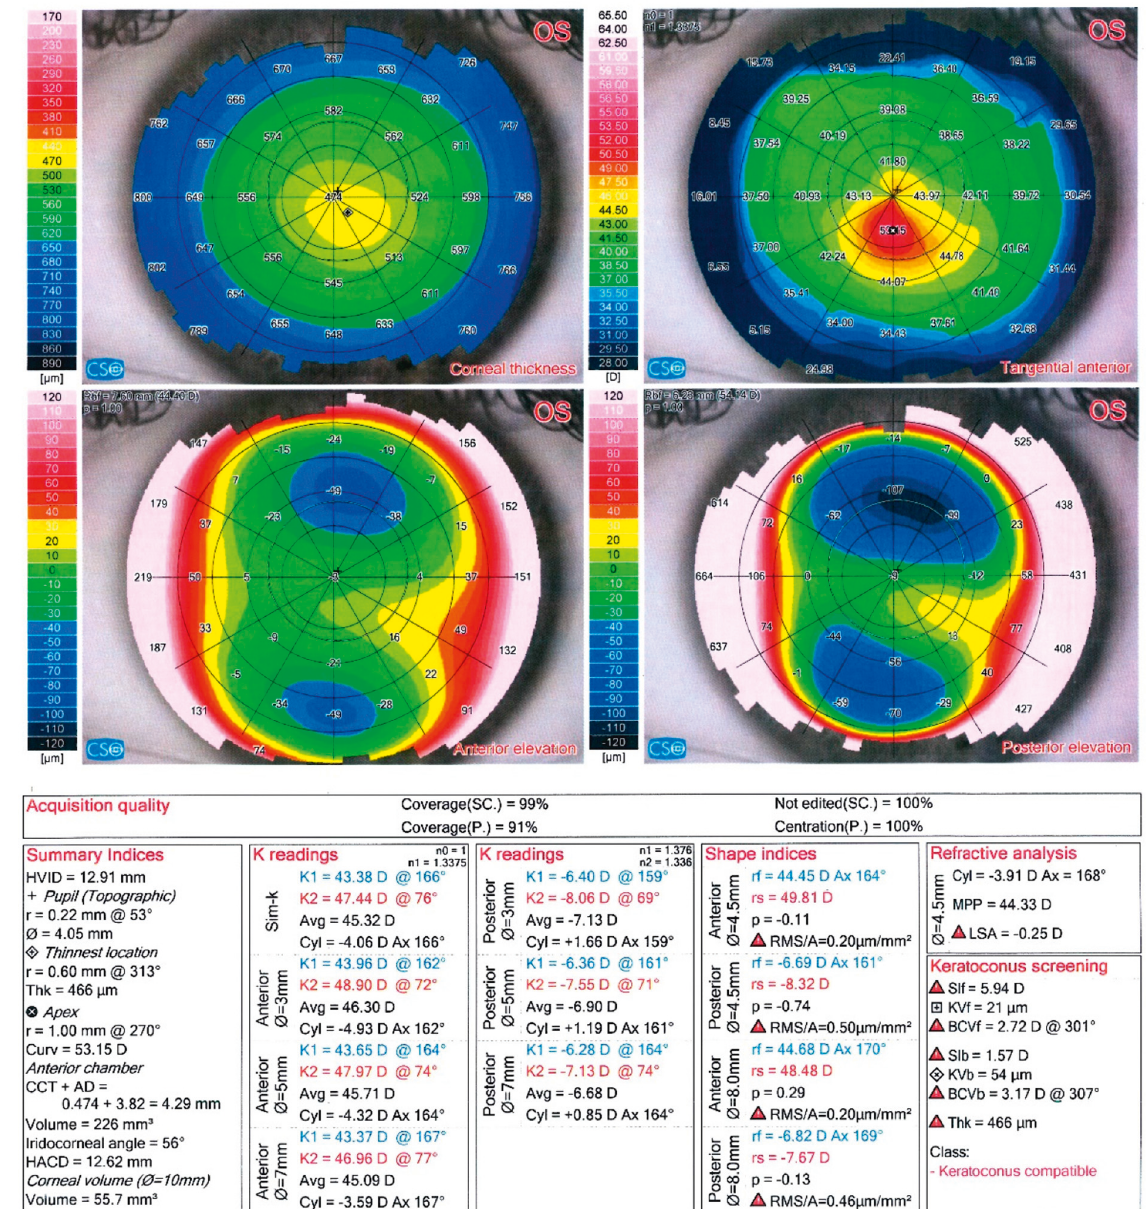
Figure 1: Sirius (v) 2.6 quad map of a case with